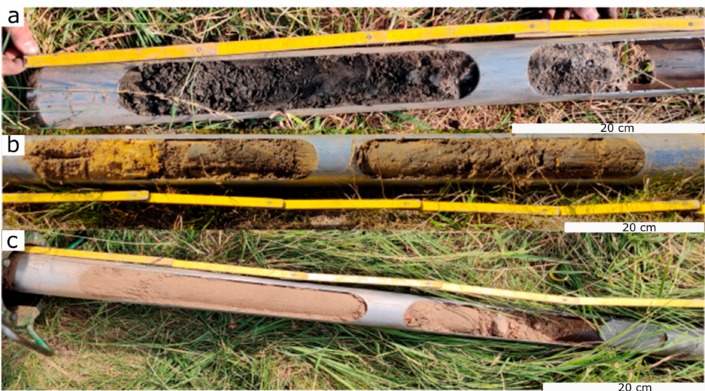
Figure 3. ( a ) Thin layer of soil (to the right), followed by a thick layer of metallurgical waste ( b ) Thick layer of brown tailings and transition to the yellow tailing (to the left). ( c ) One meter of yellow